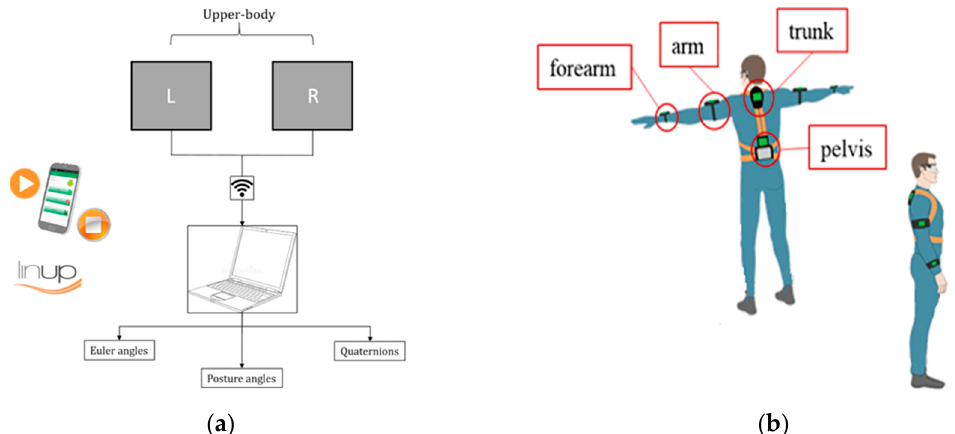
Figure 4. Wearable motion tracking system in upper-body configuration: architecture ( a ) and wearable suite ( b ).